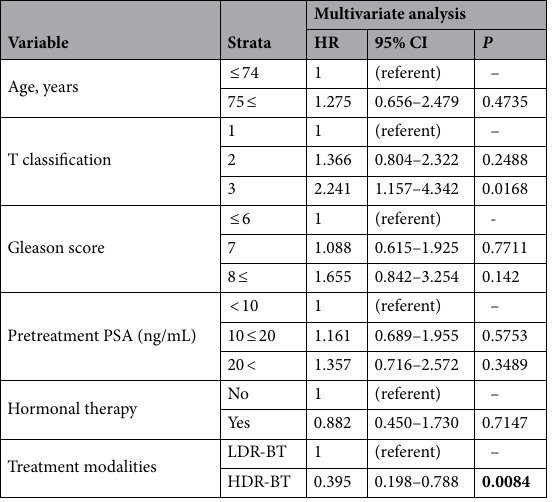
Table 2. Multi-variate analysis for biochemical control rate using Cox proportional hazards model. Bold values indicate statistically significance. CI confidence interval, HR hazard ratio, NA not available, HDR‑BT high dose rate brachytherapy, LDR‑BT low-dose-rate